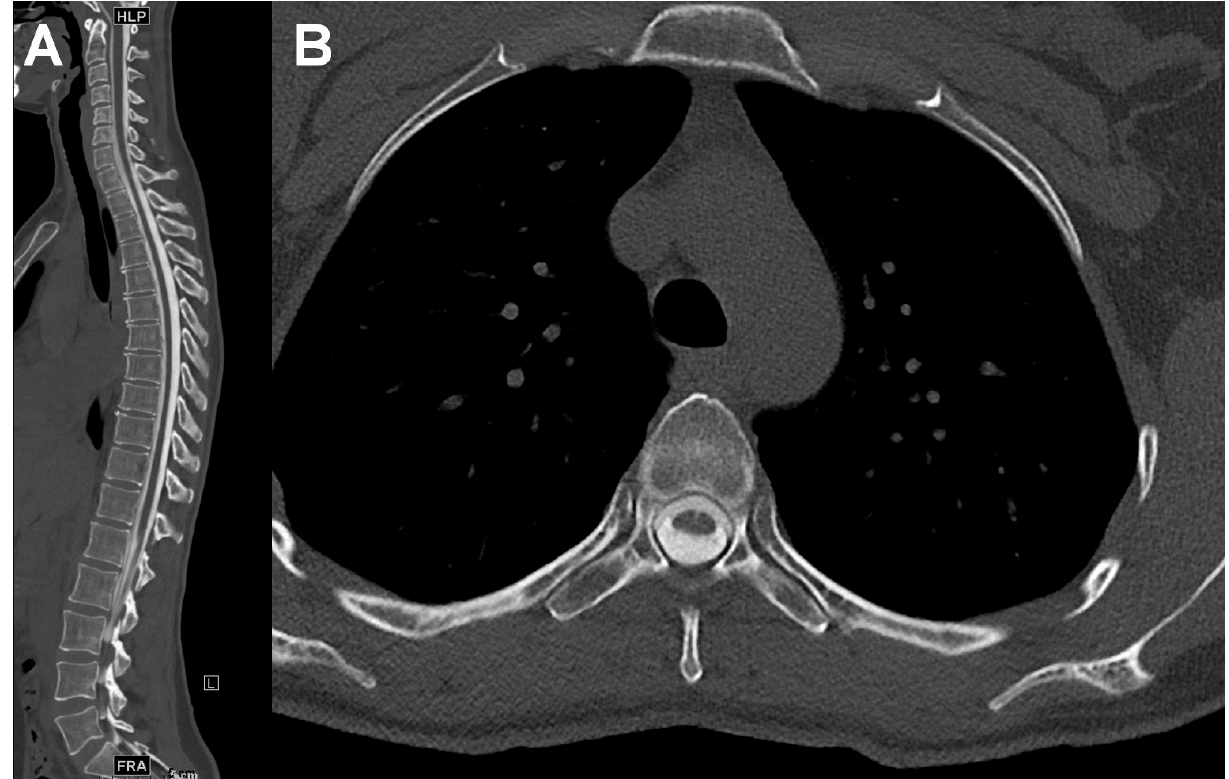
Figure 1. Image examples of a CT myelography of the whole spine of a 36-year-old female patient with suspected cerebrospinal fluid (CSF) leak in sagittal ( A ) and axial ( B ) reconstruction at level Th4.